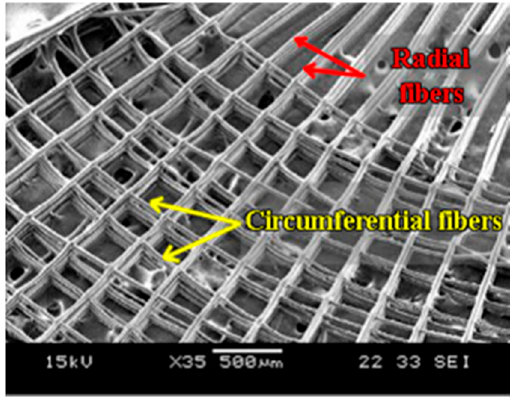
Figure 4. Fabricated meniscal scaffold (adapted from [68]).